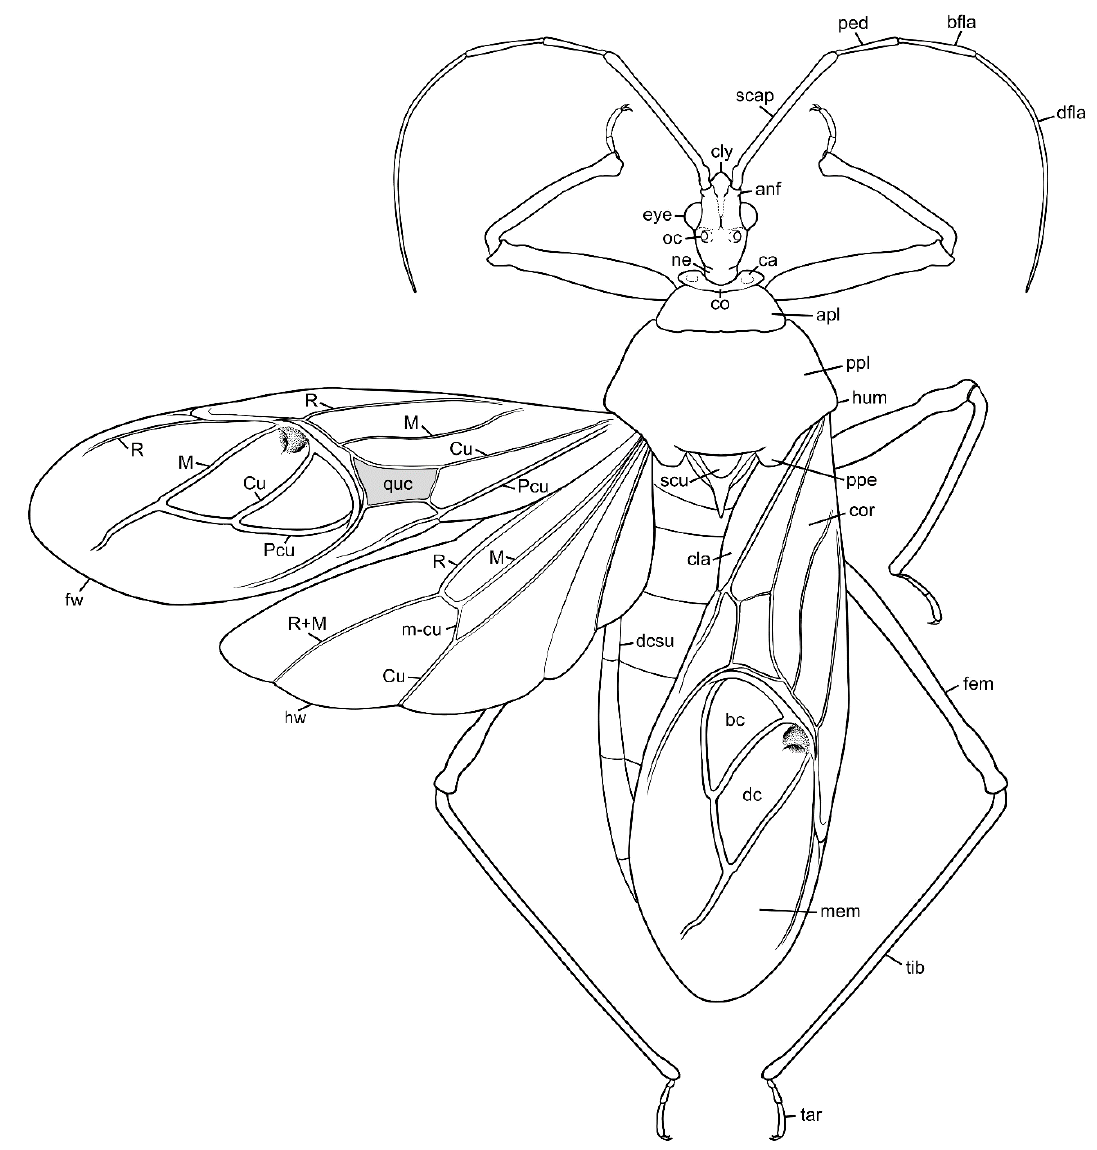
Figure 1. General morphology of Phonoctonus : and —antennifer; apl —anterior pronotal lobe; bc —basal cell; bfla — basiflagellomere; ca —callus (pl. calli); cla —clavus; cly —clypeus; co —collar; cor —corium; Cu —cubital vein; dc —distal cell; dfla —distiflagellomere; dcsu —dorsal connexival suture; fem —femur; fw —forewing; hum —humerus (pl. humeri); hw —hindwing; M —medial vein; m-cu —crossvein between media and cubitus; mem —membrane; ne —neck; oc —ocellus (pl. ocelli); Pcu —postcubital vein; ped —pedicellus of the antenna; ppe —posterior pronotal extensions; ppl —posterior pronotal lobe; quc —quadrate cell on the corium formed by the cubitus; R —radial vein; scu —scutellum; scap —scapus of the antenna; tar —tarsus; tib — tibia.